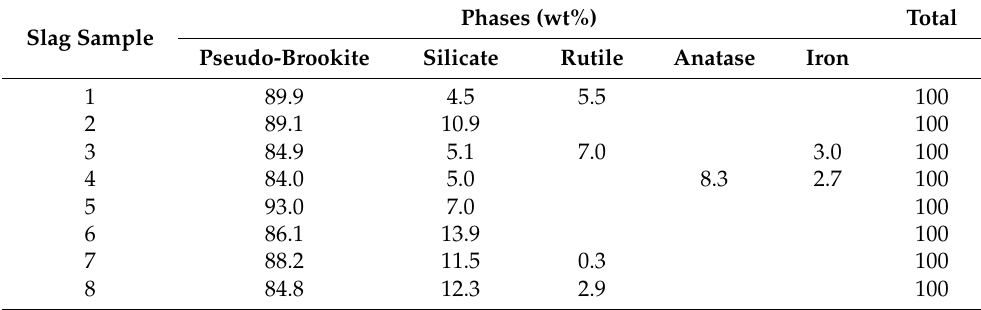
Table 3. Phases in weight (percentage) detected by XRD for each sample using the Rietfeld refinement. Slag Sample